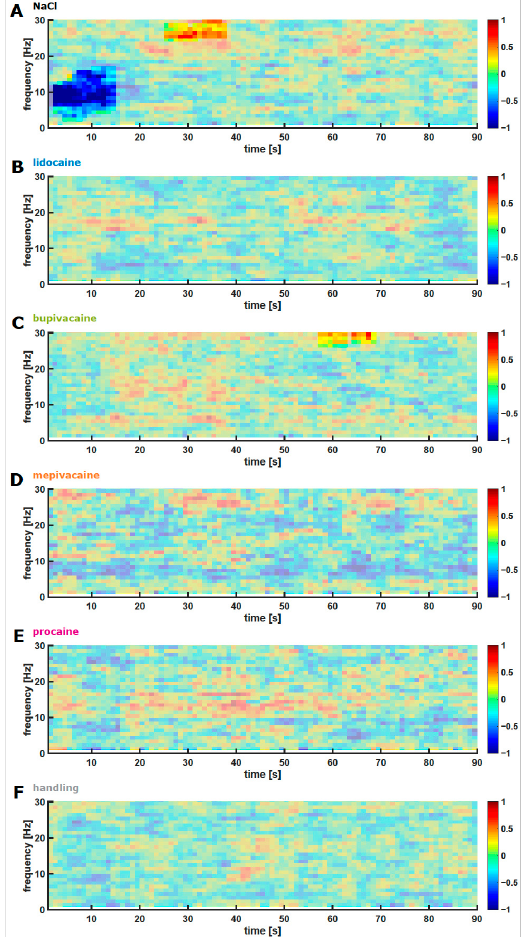
Figure 3. DSAs of the Changes in EEGs after the Scrotal Skin Incision. The DSAs present changes in EEG power over 90 s following the incision stimulus in the following experimental groups: NaCl ( A ), lidocaine ( B ), bupivacaine ( C ), mepivacaine ( D ), procaine ( E ), and no incision and handling only ( F ). The incision started at t = 0. Areas shown in bold colours indicate frequency and time